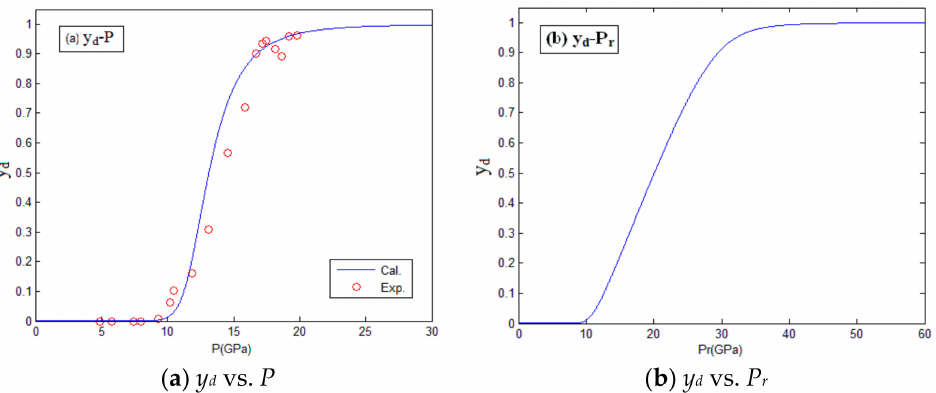
Figure 8. The relation between reaction degree and impact pressure. ( a ) The relation between the degree of reaction and pressure before material reaction; ( b ) The relation between the degree of reaction and pressure after material reaction.